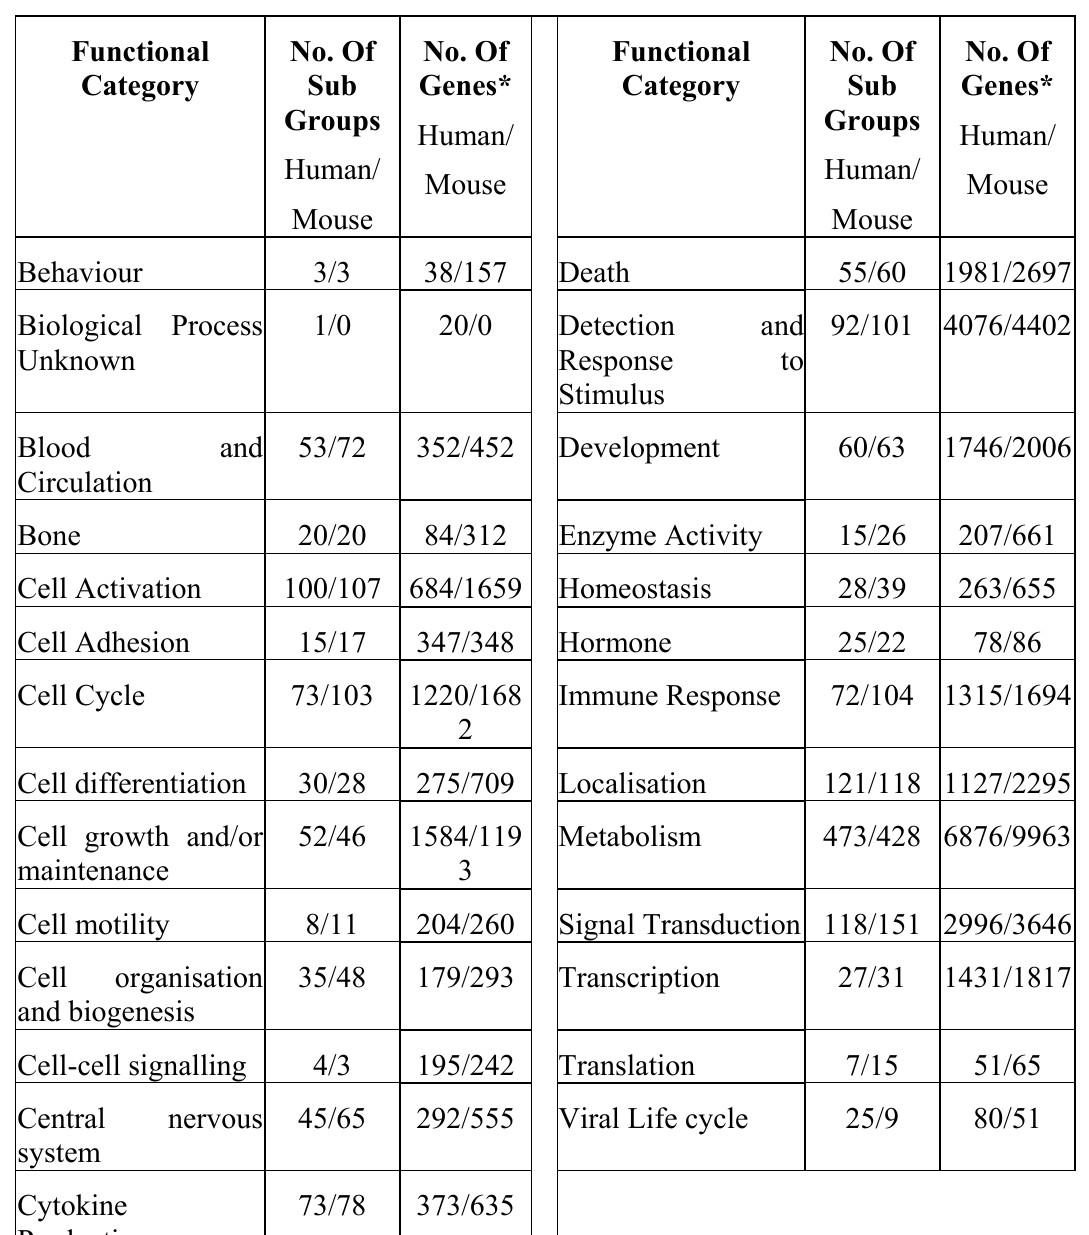
Table 1. 27 Parent biological categories and corresponding children sub-groups contained within the Immune